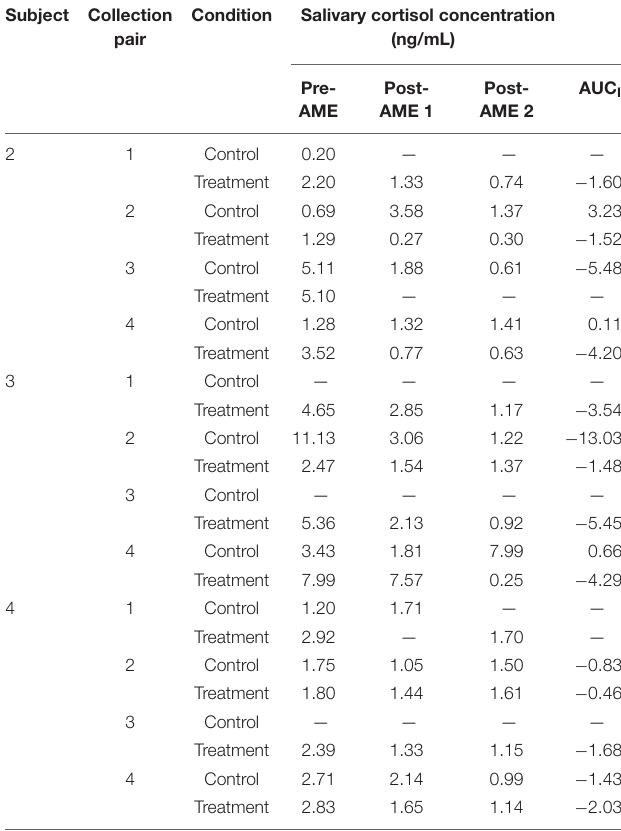
TABLE 5 | Salivary cortisol concentrations and areas under the